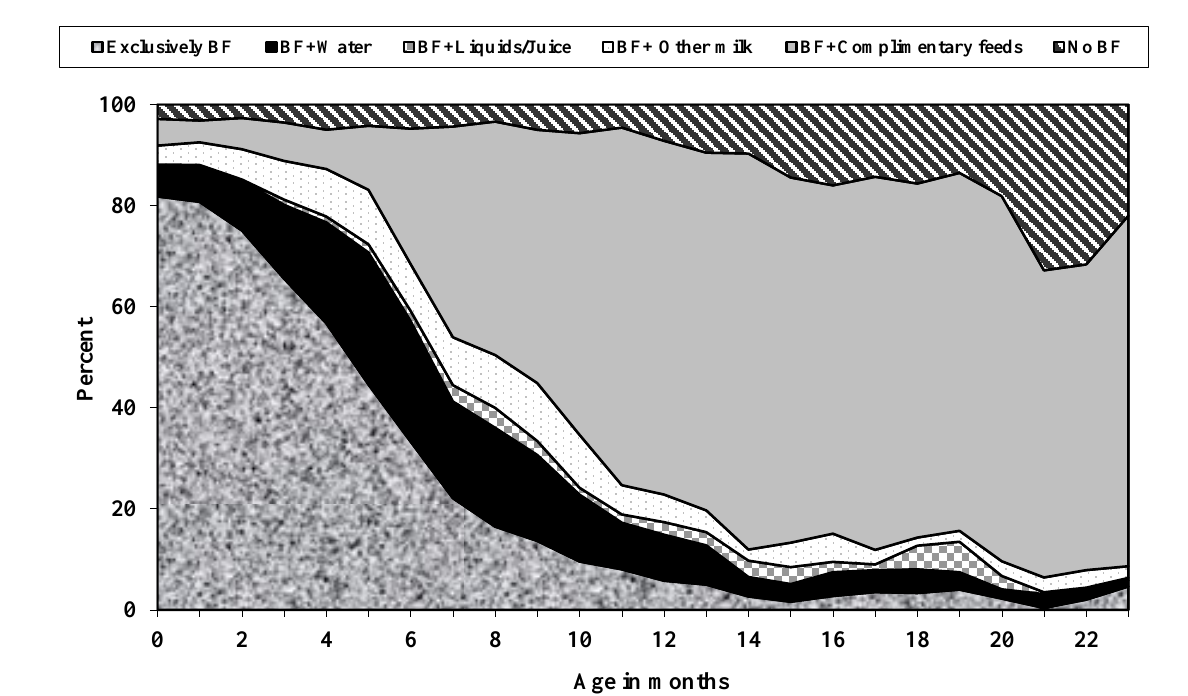
Figure 1. Distribution of children by breastfeeding (BF) status, according to age among adolescent mothers in India, 2015 – 2016.